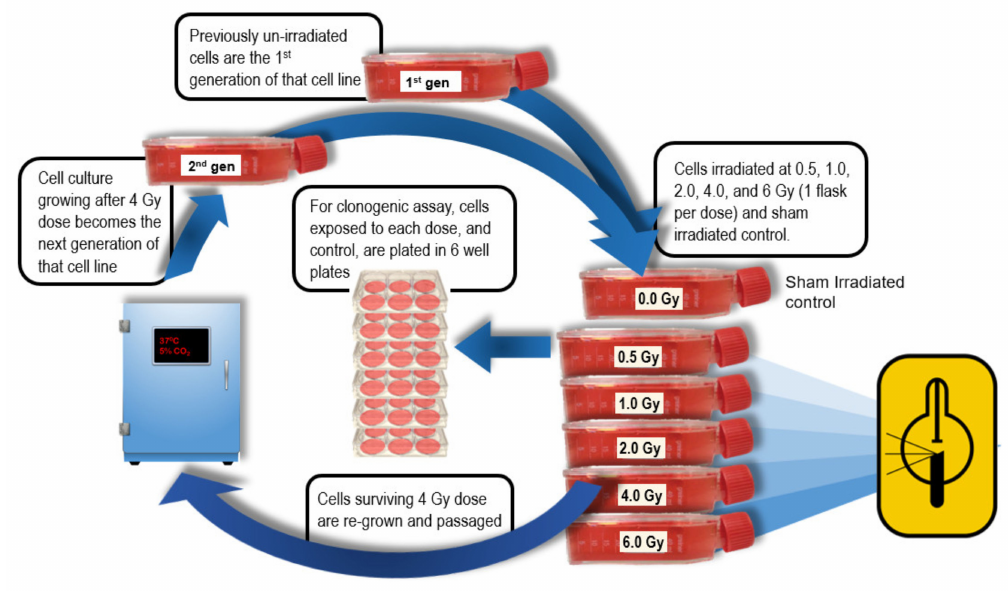
Figure 1. Generational development of cell line cultures following 4 Gy fractions. Cells from the T25 flask that received 4 Gy were re-cultured to become the next generation of that cell line then